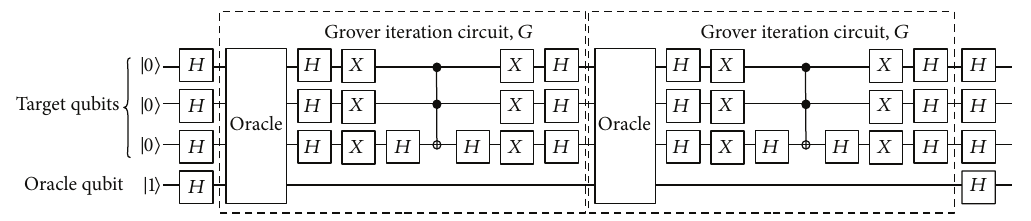
Figure 7: Modelling of 3 -qubit Grover’s search based on quantum gates.